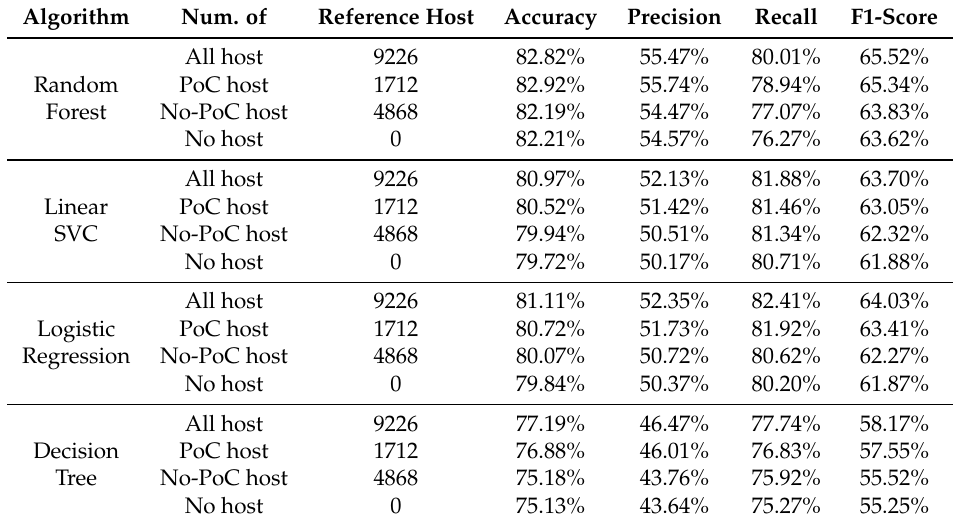
Table A5. Test set 5 results of the exploit prediction experiment based on Reference